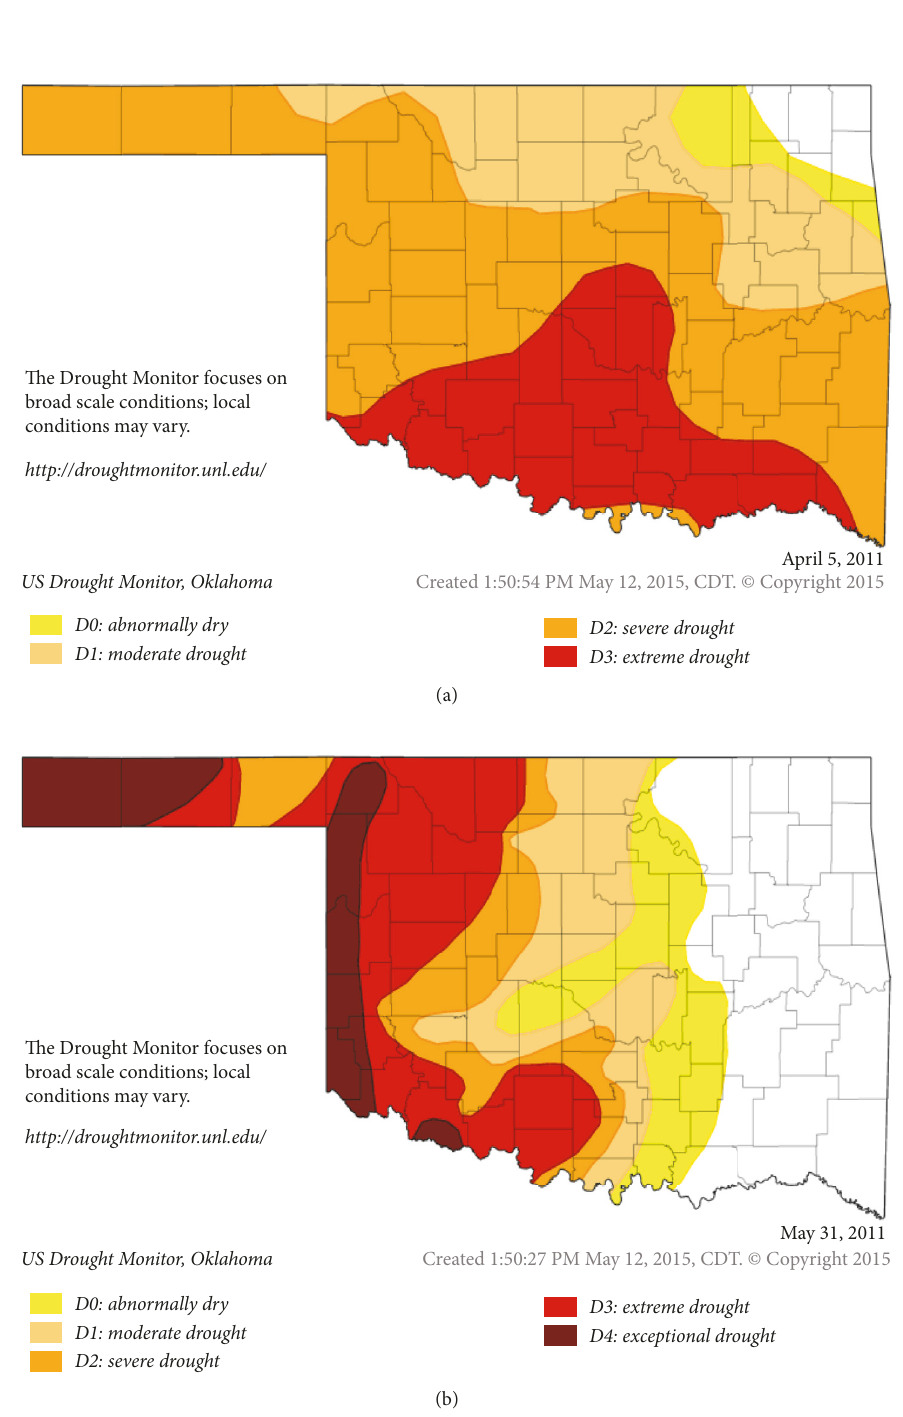
Figure 3: United States Drought Monitor plot showing the categorization of drought conditions on April 5 (a) and May 31 (b), 2011 (adapted from